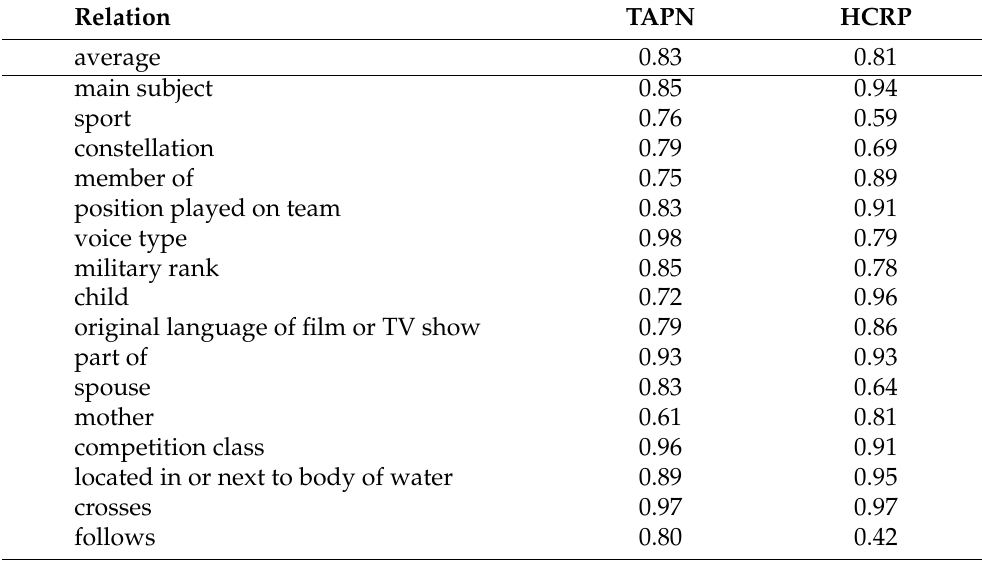
Table 5. The performance of our proposal and HCRP in terms of precision(%) on test